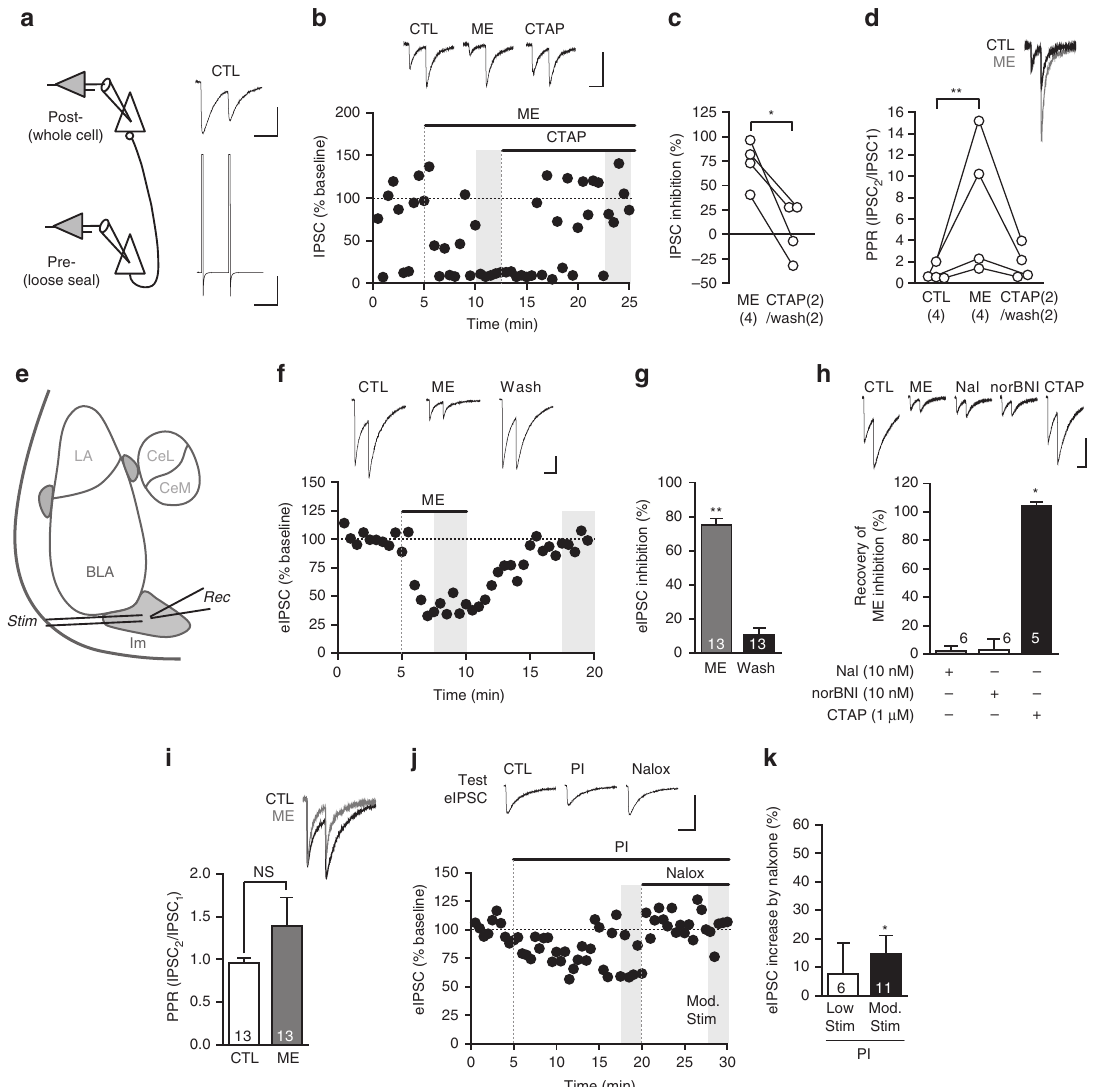
Figure 6 | Endogenously released opioids modestly inhibit local GABA ITC synapses. ( a ) Paired recordings of synaptically connected ITCs. Example pre - synaptic (lower trace) and post synaptic (upper trace) currents following voltage pulses (200mV) to the pre-synaptic cell. ( b – d ) ME (10 m M) strongly inhibits synaptic transmission between paired ITCs and increases PPR, both are reversed by washout or CTAP. Data showing ( b ) IPSCs and time plot of single representative experiment and ( c ) scatter plot (* P o 0.05, Friedman’s with Fisher’s post hoc tests). ( d ) Scatter plot of PPR and example IPSCs normalized to first peak (** P o 0.01, Friedman’s with Fisher’s post hoc tests). ( e ) Stimulation/recording locations for local GABAergic-ITC synapses. ( f , g ) ME (10 m M) strongly inhibits local eIPSCs amplitude, ( f ) eIPSCs and time plot of single representative experiment, ( g ) summary bar chart (** P o 0.01, paired t -test versus CTL). ( h ) ME inhibition is mediated exclusively by MOR. Example eIPSCs and bar chart showing percent recovery from ME inhibition by application of DOR (Naltrindole, 10nM), KOR (norBNI) and MOR (CTAP) selective antagonists (* P o 0.05, paired t -test, CTAP versus ME). ( i ) ME has no effect on PPR and quickens synaptic decay kinetics; example eIPSCs normalized to first peak showing no change in PPR but faster synaptic decay and summary bar chart of PPR (NS, not significant, paired t -test). ( j , k ) In the presence of peptidase inhibitors (PI), naloxone only increased moderate stimulus evoked test eIPSCs. ( j ) Test eIPSCs and time plot of single representative experiment. ( k ) Bar chart showing modest increase in test eIPSC by naloxone but no change in low stimulus eIPSCs. (* P o 0.05, paired t -test versus PI). Data are represented as mean ± s.e.m. Highlighted regions on time plot represents region sampled for bar charts. Scale bars, ( a ) 50ms, 5nA; ( a , b ) 50ms, 200pA; ( d – f ) 50ms,